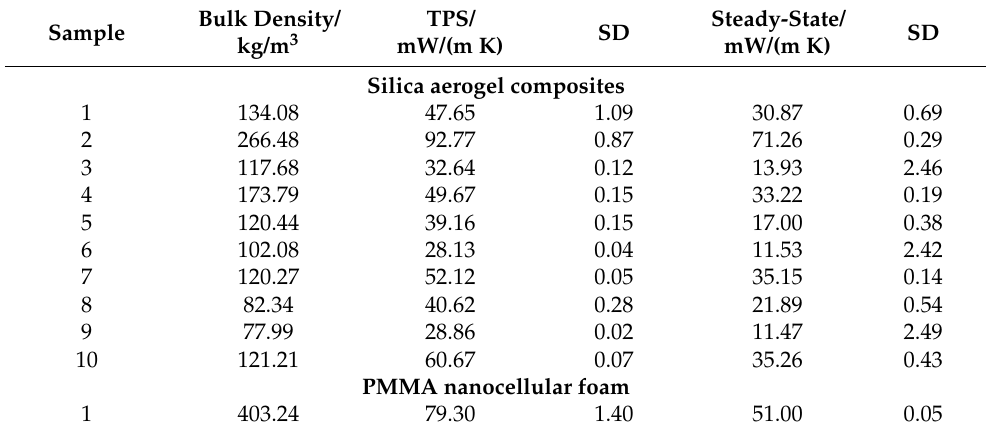
Table 2. Thermal conductivity measurements for insulating samples by the transient method and the steady-state method—a